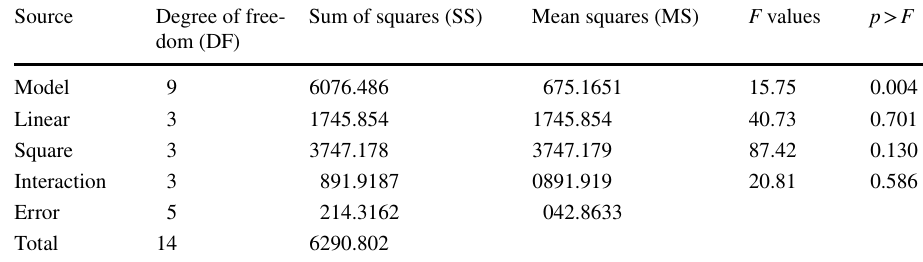
Table 5 Analysis of variance (ANOVA) for the RSM model